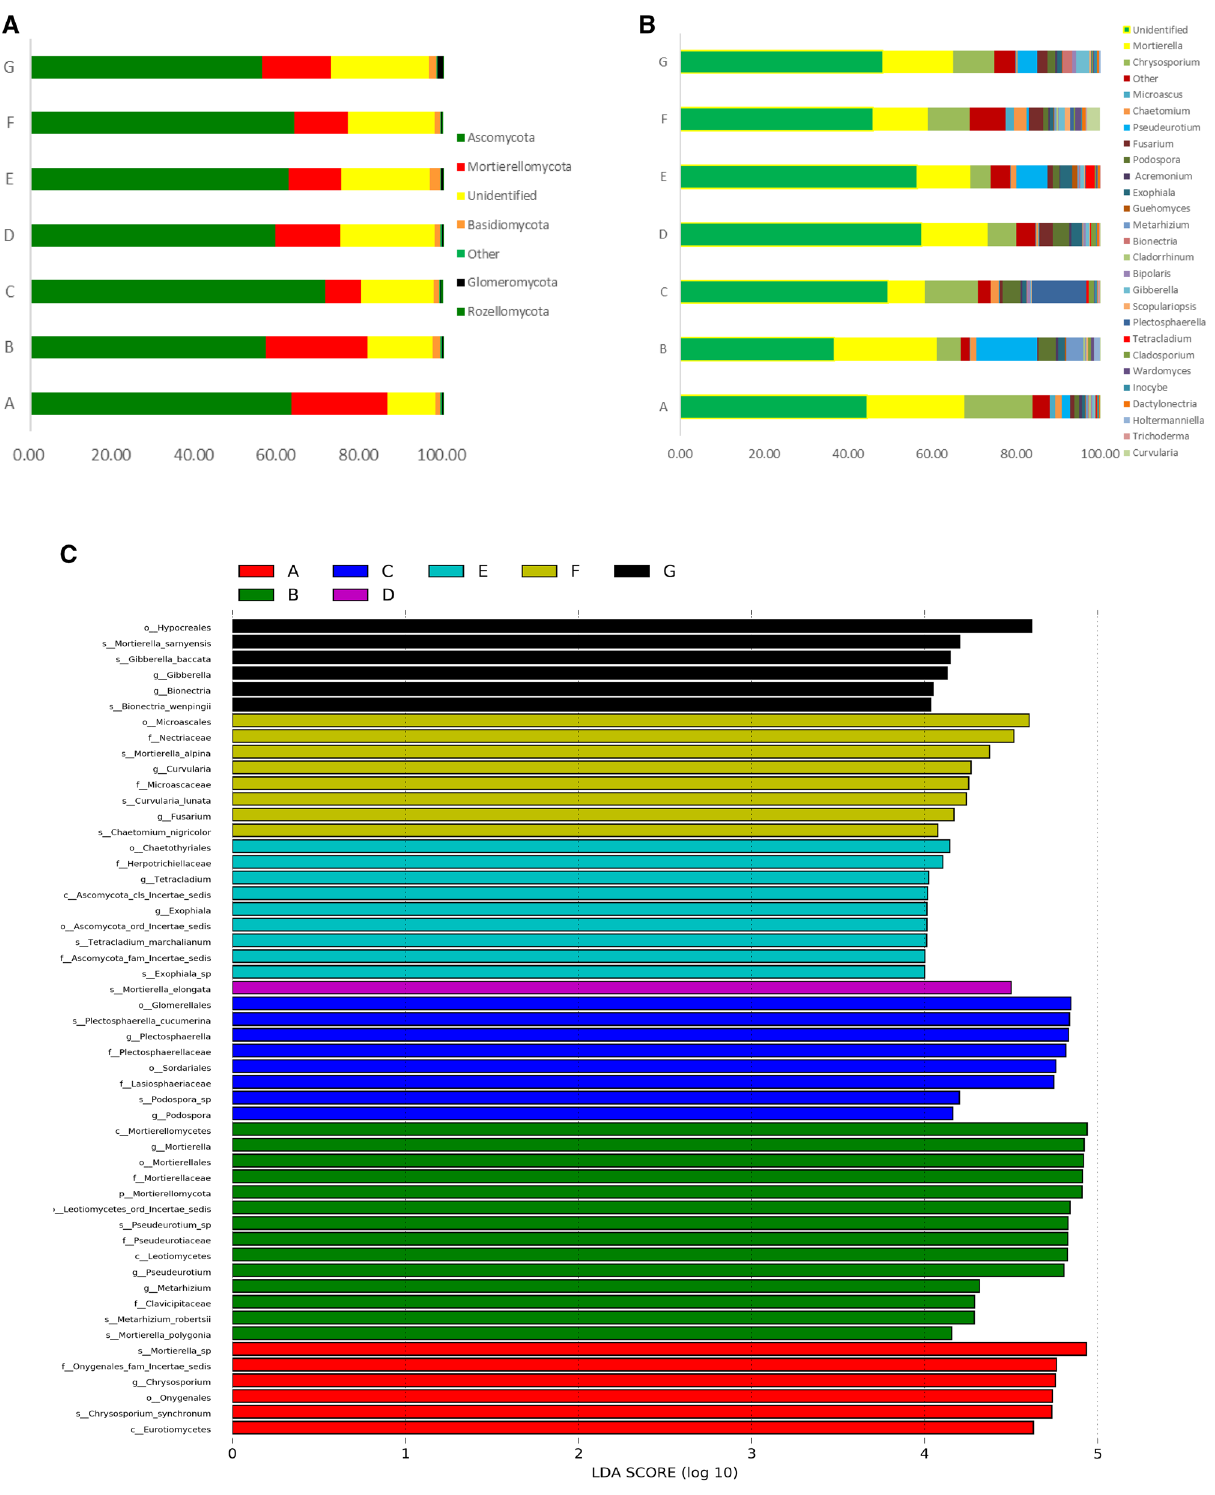
Figure 3. ( A ) Composition of the different fungal communities at the phylum level in seven rhizosphere soil samples. The relative abundance of different fungal phylum within the different communities are shown in different colors. Unidentified means there was no taxonomic information, and Other means many function group. ( B ) Composition of the different fungal communities at the genus level in seven rhizosphere soil samples. The relative abundance of different fungal genus within the different communities are shown in different colors. Unidentified means there was no taxonomic information, and Other means many function group. ( C ) LDA score of the fungi of different cropping year. The figure shows species whose LDA Score is greater than the set value (LDA score > 2, less-strict set to 2; More-strict was set as 4), that is, biomarkers with statistical differences between groups. The length of the bar chart represents the significance of the different